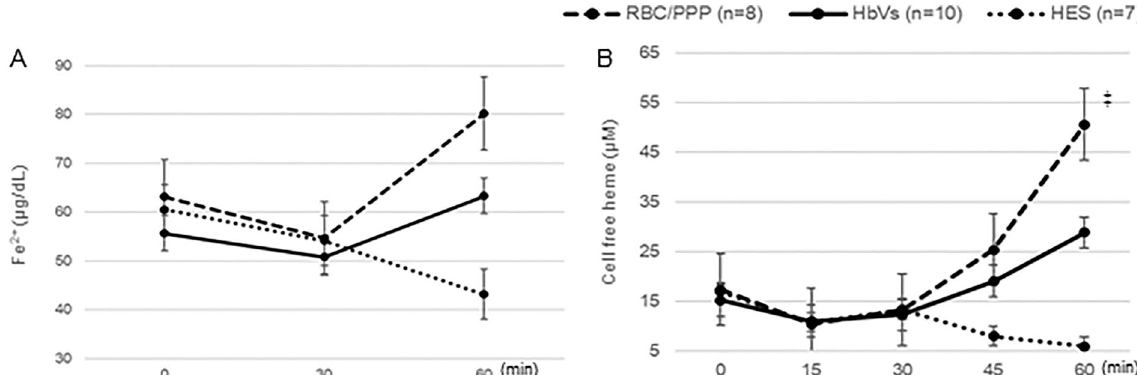
Figure 6. Changes in the levels of Fe 2+ and cell-free heme. ( A ) The values of Fe 2+ tends to increase in the HbV and RBC/PPP groups after 30 min. ( B ) The concentration of cell-free heme is increased after RBC transfusion or HbV infusion, with the increase being greater after RBC transfusion than after HbV infusion. ‡ P < 0.05, The concentration of cell-free hemoglobin increased after RBC transfusion than after HbV infusion. Data shown are the mean ± standard deviation. HbV hemoglobin vesicles, HES hydroxyethyl starch, RBC red blood cell, RBC/ PPP red blood cells with platelet-poor